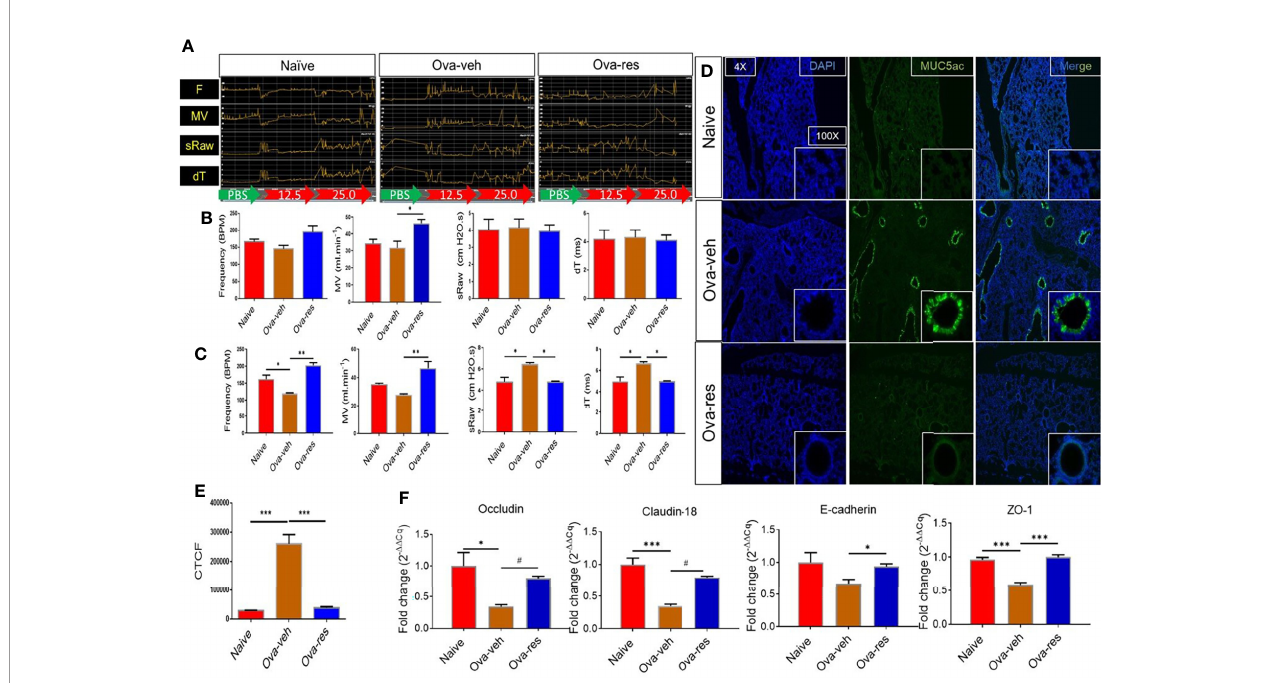
FIGURE 1 | Effect of resveratrol on physiological functions of the lungs in OVA-administered mice. BALB/c mice were initially sensitized by intraperitoneal injection of ovalbumin followed by an intranasal challenge on day 7. These mice received vehicle (Ova-veh) or RES (Ova-res) on days 1-14. On day 15, the mice were chosen randomly and placed in one of 4 chambers of Buxco instrument for pulmonary function analysis or sacri fi ced for other examination. (A) Pulmonary function tests included changing patterns of frequency (F), mean volume (MV), speci fi c airway resistance (sRaw) and delay time (dT) among naïve, Ova-veh and Ova-res group as baseline response (BL, green arrow), PBS exposure response (red arrow), and 25 mg/ml methacholine response (Mch, red arrow). Bar graphs present the statistical comparison of frequency, MV, sRaw and dT among naïve, Ova-veh and Ova-res group at the baseline response (B) and after challenge with 25 mg/mL methacholine (C) . (D) Immuno fl uorescent staining showing the expression of MUC5ac protein in lung sections of naïve, Ova-veh and Ova-res group mice observed under Leica microscope. Statistical comparison of MUC5ac protein expression among naïve, Ova-veh and Ova-res group (E) . RT-qPCR data to measure the expression of tight junction proteins, occludin, claudin-18, E-cadherin and ZO-1 in puri fi ed epithelial cells from mice (F) . Vertical bars in all panels represent Mean+/-SEM data from groups of 5 mice. *p<0.05, **p<0.01, ***p<0.001, #